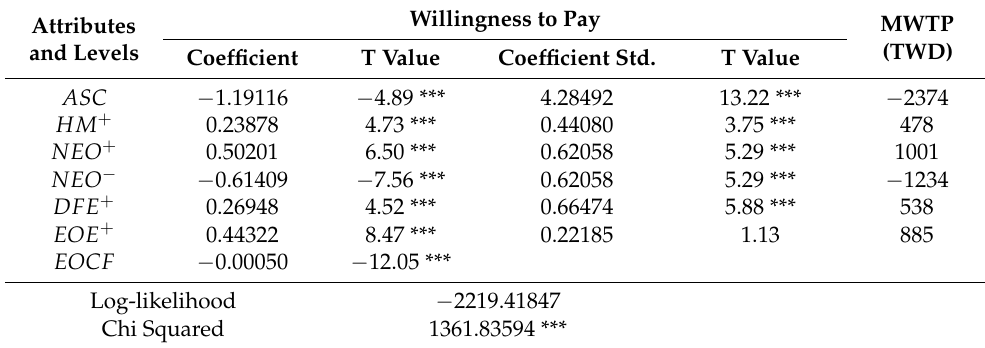
Table 3. Results of the RPL Model.